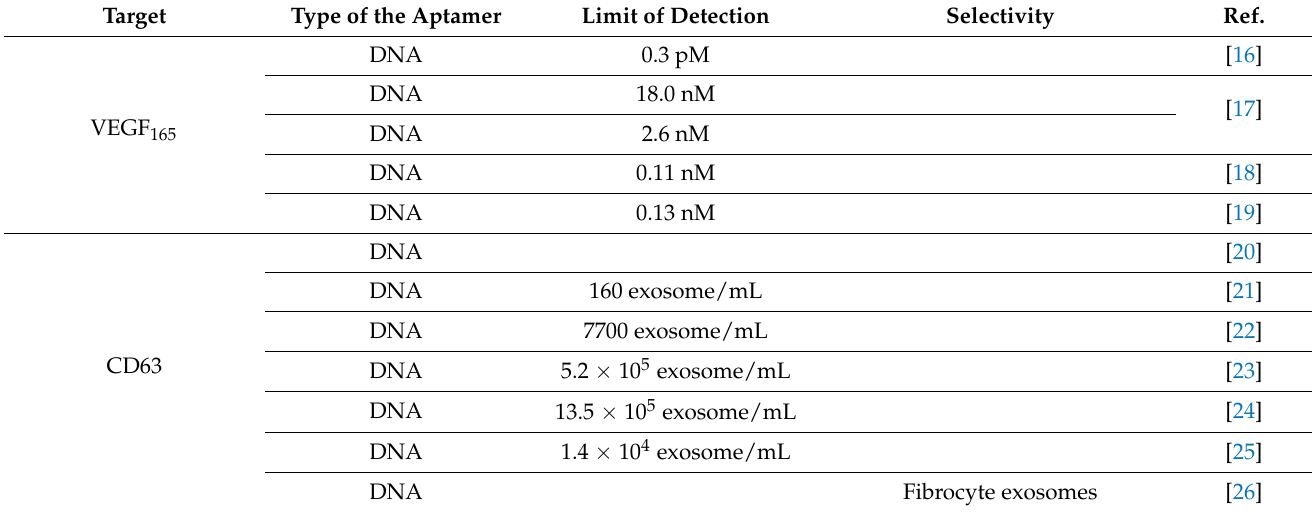
Table 2. Colorimetric aptasensors for the detection of disease